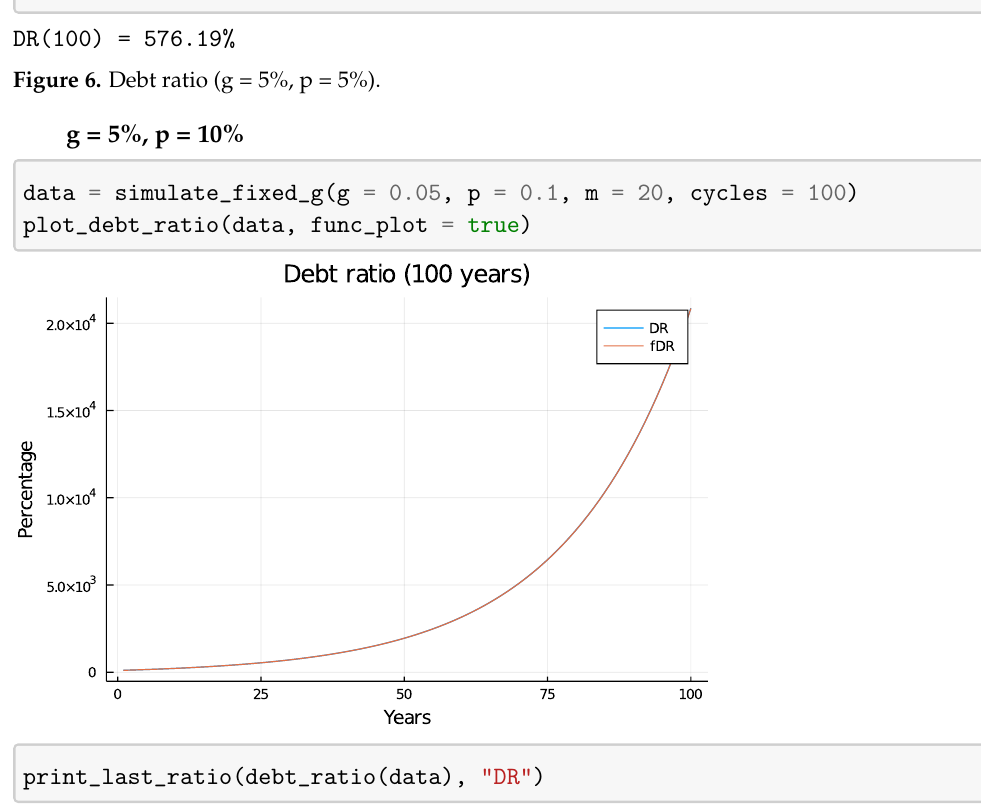
Figure 7. Debt ratio (g = 5%, p =